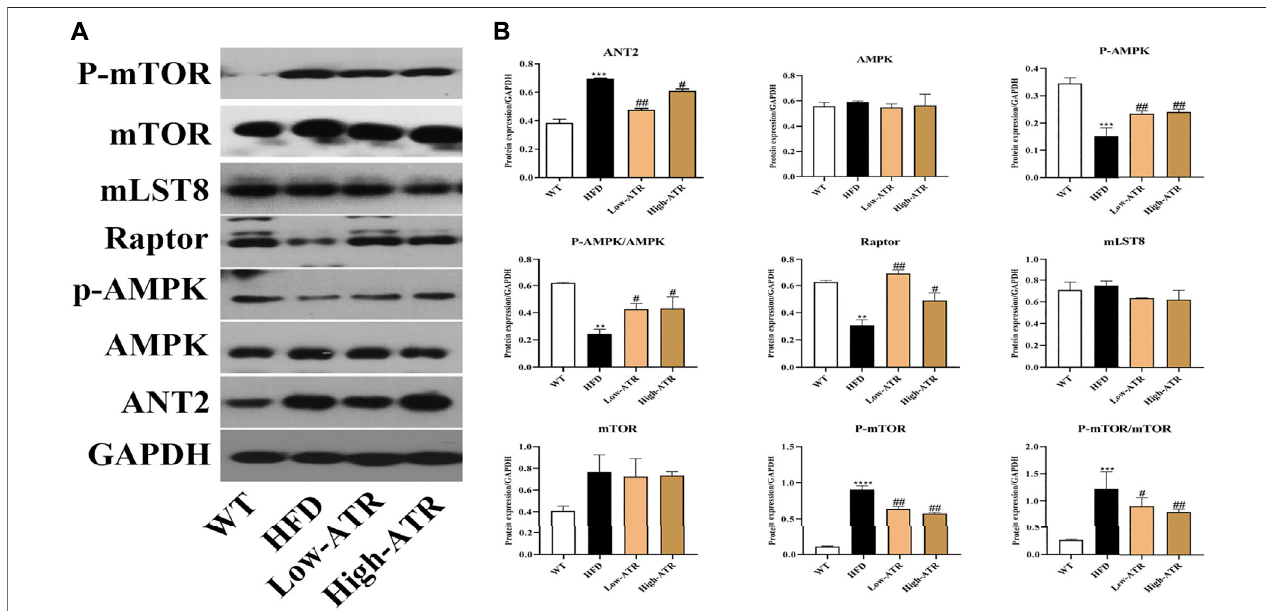
FIGURE3| TheregulationofANT-AMPK-mTORC1signalingpathwaybyATR. (A) ImmunoblotanalysisresultsofANT2,AMPK,phosphorylatedAMPK(p-AMPK), Raptor,mLST8,mTOR,andphosphorylatedmTOR(p-mTOR). (B) TherelativeproteinexpressioninreferencetoGAPDH.Dataareexpressedasmean ± SD( n (cid:2) 8).* p < 0.05, ** p < 0.01, *** p < 0.001 (*represents HFDgroups compared withthe WT group). # p < 0.05, ## p < 0.01, ### p < 0.001 ( # representsATRtreatmentscompared with the HFD group). WT (cid:2) control group and HFD (cid:2) high-fat diet group.